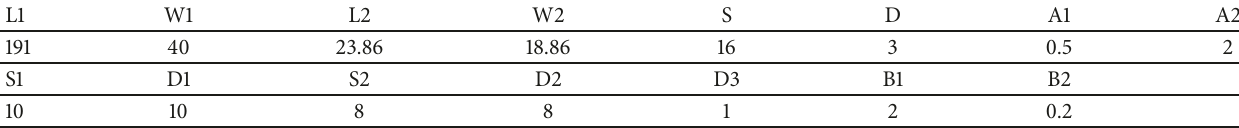
Table 1: Design parameters of the proposed antenna in Figure 11 (unit: